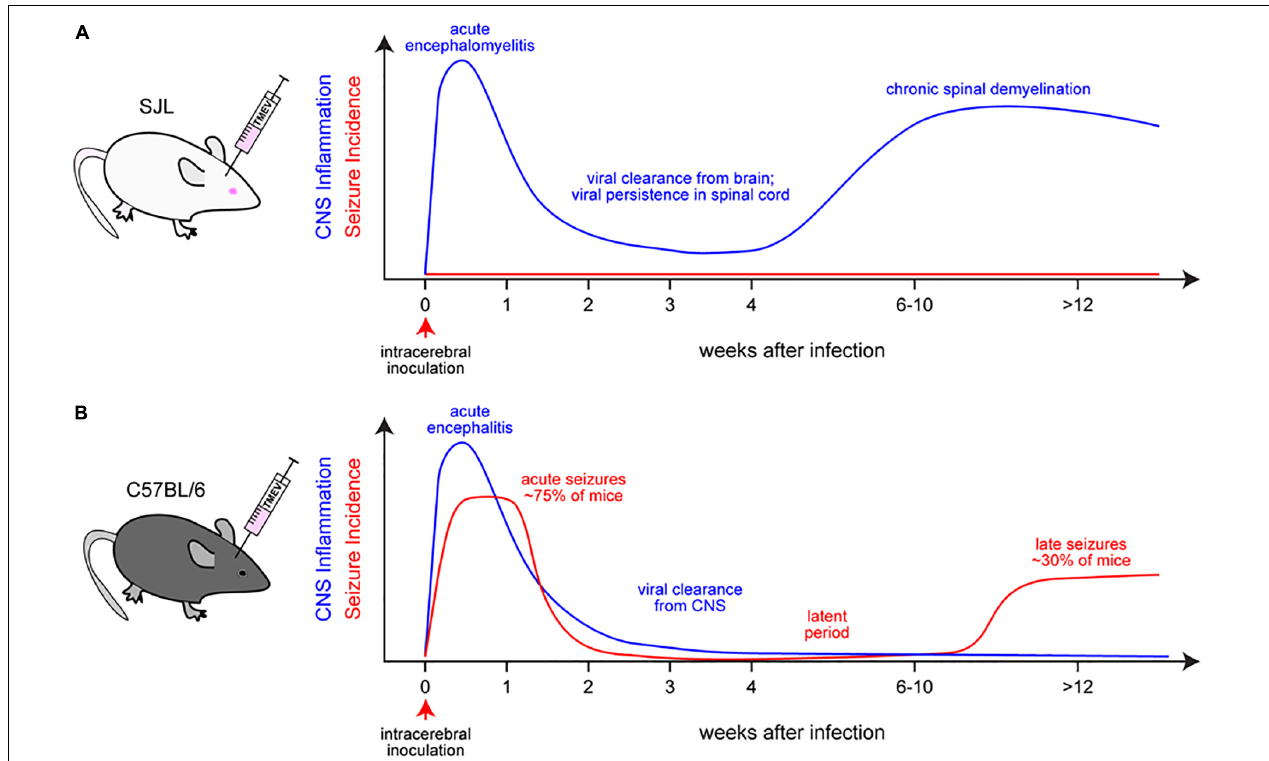
FIGURE 6 | Theiler’s murine encephalomyelitis virus (TMEV) infection as a model for multiple sclerosis (A) or epilepsy (B) . (A) Intracerebral inoculation of SJL mice with low neurovirulent Theiler’s original (TO) subgroup strains of TMEV (such as DA or BeAn) results in a biphasic disease course consisting of an acute encephalomyelitis followed by demyelination of the spinal cord. During the acute phase, neurons within the hippocampus, cerebral cortex, and spinal cord are infected. However, later, as the virus is cleared from the brain, persistent infection in spinal glia results in chronic inflammation, demyelination, axonal degeneration, and astrogliosis, resembling the pathological alterations observed in MS. Notably, seizures are not observed in TMEV-infected SJL mice at any point during the disease course. (B) Intracerebral inoculation of C57BL/6 mice with TMEV results in acute viral encephalitis that is marked by rapid monocytic and neutrophilic infiltration followed by entry of antiviral T cells, resulting in viral clearance from the host. The virus does not persist in these animals. In contrast to SJL mice, damage to hippocampal neurons is a prominent feature in B6 mice and is associated with impaired learning and memory and induction of anxiety behaviors. Early symptomatic seizures occur in ∼ 75% of mice during the acute phase and are associated with monocyte-derived cytokines such as IL-6 and TNF- α . The acute symptomatic seizures are observed over ∼ 2–10 days following infection, followed by a seizure-free latent phase of several weeks, after which about 30% of the infected mice develop spontaneous